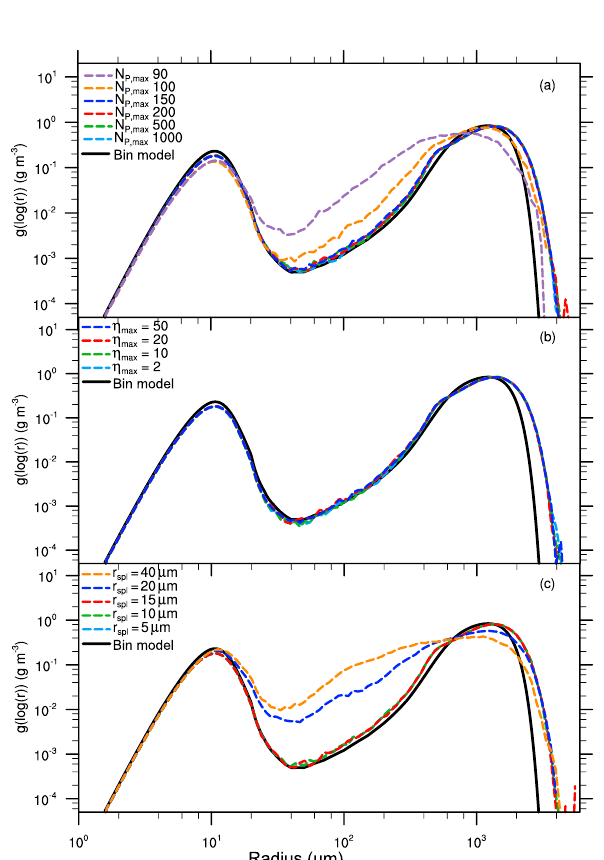
Figure 12. Mass density distribution for the box simulation after 3600s. The black solid line denotes the solution of Wang et al. (2007). In (a) , sensitivity studies for different values of N P,max are presented. In (b) , simulations for different values of η max are shown. In (c) , results for different splitting radii are displayed. All sensitivity studies are conducted using the splitting mode G .